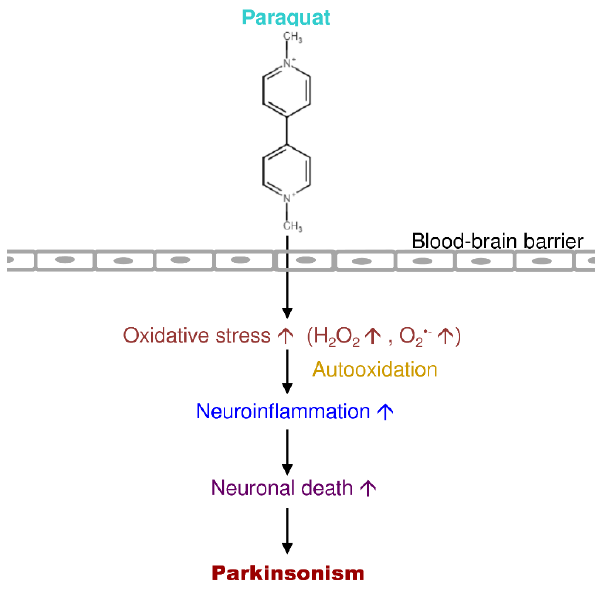
Figure 6. Putative mechanism of action of paraquat in PD progression.